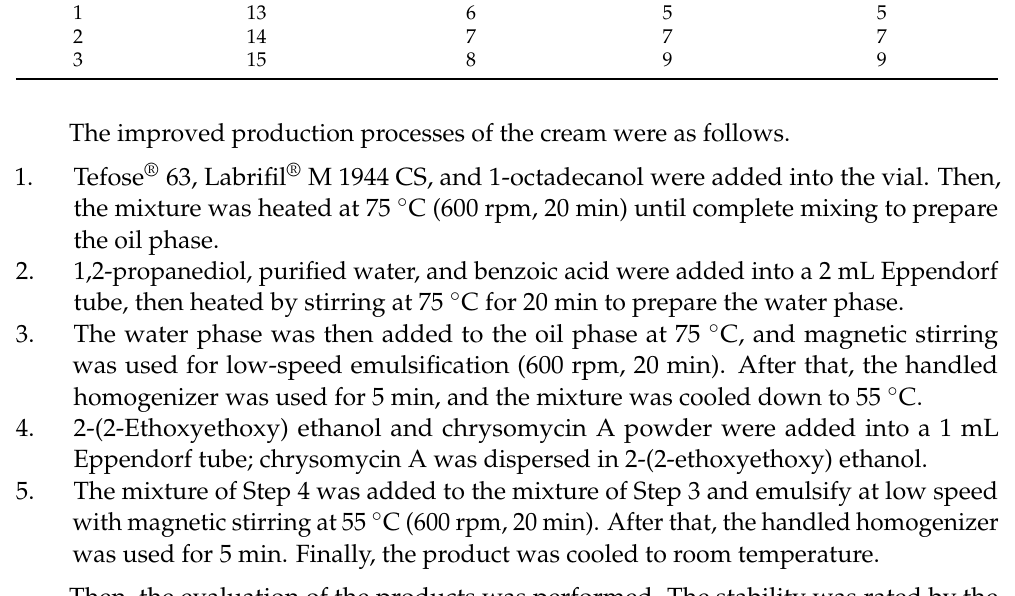
Table 2. Influencing factors and levels of cream formula (after optimization).